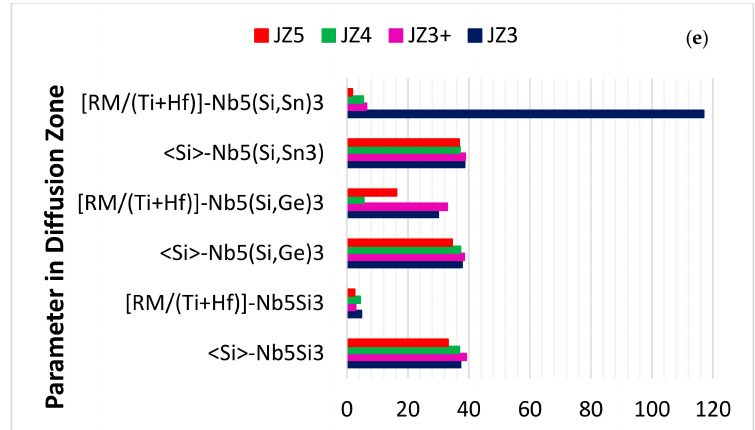
Figure 11. Data for 1200 ◦ C for phases in di ff erent alloys. ( a ) Data for (Nb, W) ss , parameters < Si > , (Mo + W) / Ti, ( b ) data for Nb < Si > , RM / (Ti + Hf), ( c ) data for A15-Nb < Si > , 5 Si 3 , parameters 3 X, parameters Mo / W, ( d ) data for A15-Nb 3 X, parameters Ta / W or Mo / W, ( e ) data for phases in the di ff usion zone of the alloys JZ3, JZ3 + [27], JZ4 and JZ5. RM = Mo or Ta, < Si > = Al + Ge + Si + Sn. Note that < Si > = Al + Ge + Si + Sn when used for the A15 phase. Table 6. Phases in the di ff usion zones and in the bulk of the alloys JZ3 and JZ3 + [47] and JZ4 and JZ5 after isothermal oxidation at 1200 ◦ C. In italics are data for specific phases in heat-treated alloys. Phase Alloy Di ff usion